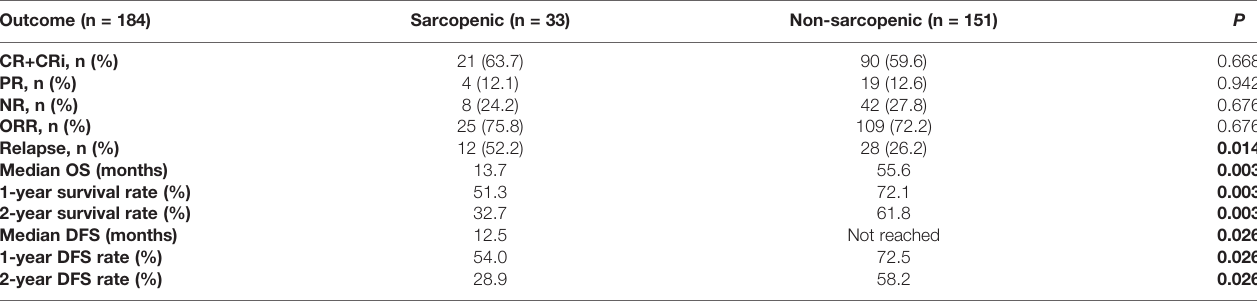
CR, complete remission; CRi, CR with incomplete hematologic recovery; PR, partial remission; NR, no remission; ORR, overall response rate; OS, overall survival; DFS, disease-free survival. Bold values mean the P values were <0.05 and of statistical signi fi